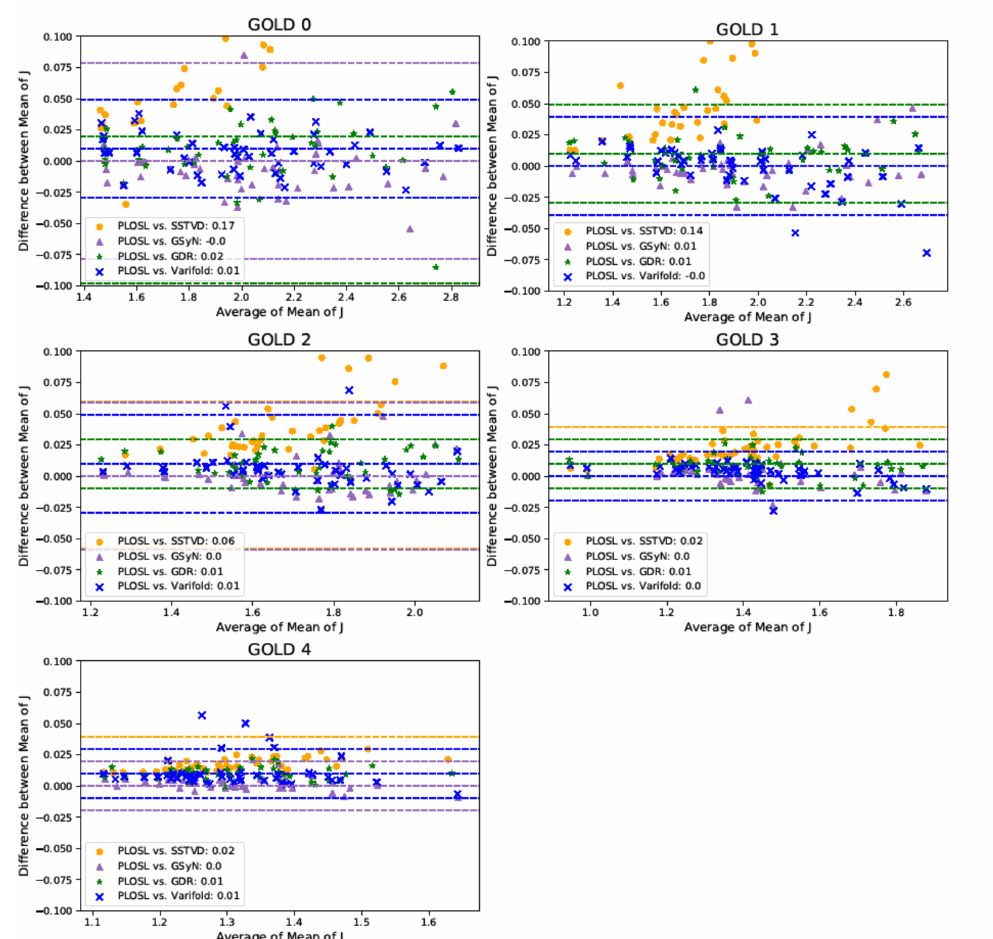
Figure 7. Multiple Comparison Bland–Altman Plots of Mean Jacobian. The shapes and colors in the legend show the Bland–Altman plot for a given algorithm comparison. There are three dashed lines for each comparison corresponding to the average difference and to the 95% limits of agreement, i.e., the average difference ± 1.96 standard deviation (SD) of the difference. The color of the dashed lines correspond to the comparison denoted in the legend. Some of the dashed lines may appear to be missing, but that is because they are covered up by other dashed lines or out of range of the y